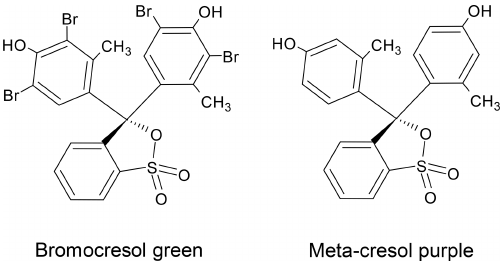
Figure 1. Chemical structure of bromocresol green (BCG) and meta-cresol purple